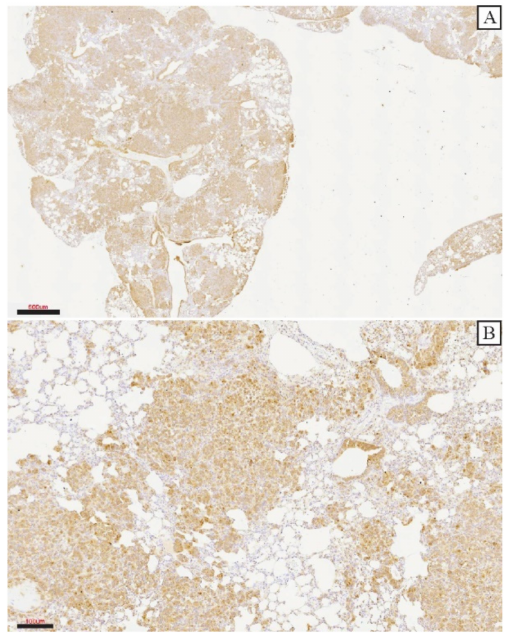
Figure 6. Immunohistochemistry at ( A ) low and ( B ) high magnification for MXRA8 in lung metastases from MDA-231EV primary tumors. Scales bars are 600 µ m for ( A ) and 100 µ m for ( B